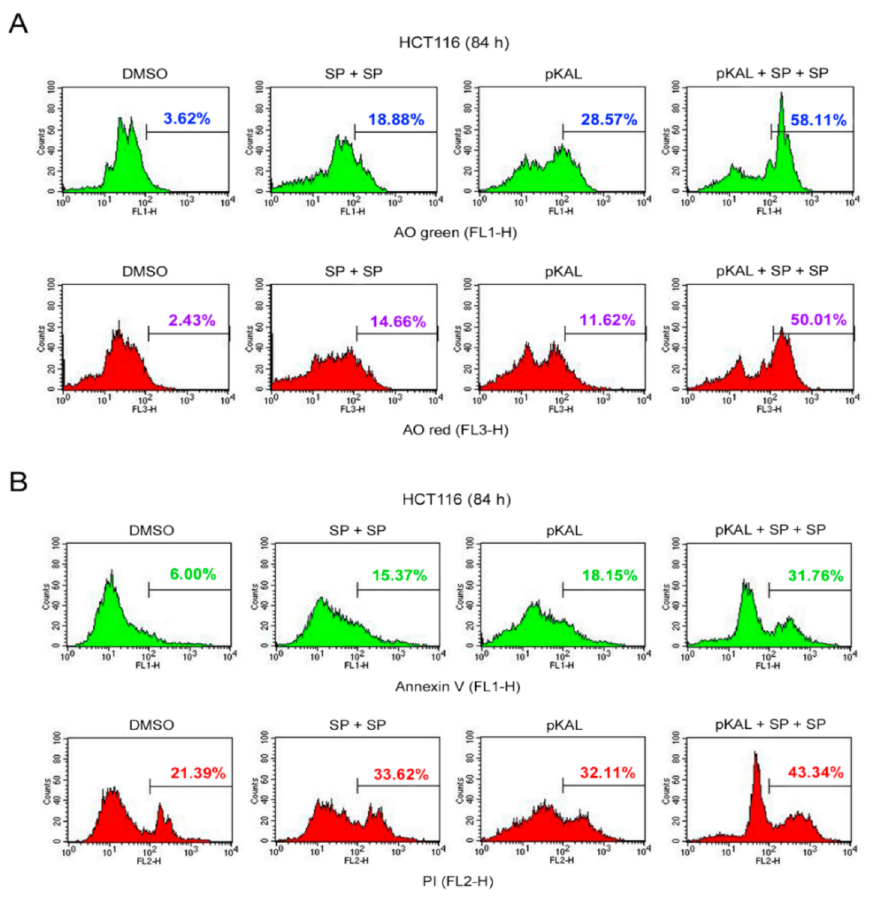
Figure 9. Effect of twice sequential treatments of SP600125 on the regulation of DNA conformational change, acidic vesicles, apoptosis, and PI uptake caused by pKAL: HCT116 cells were grown with 50 µ g/mL pKAL for 12 h, treated with 2 µ g/mL SP600125 for 24 h, and then once more treated with 2 µ g/mL SP for 48 h shown in ( A ) flow cytometric analysis of AO green- and red-stained cells and ( B ) flow cytometric analysis of annexin V/PI-stained